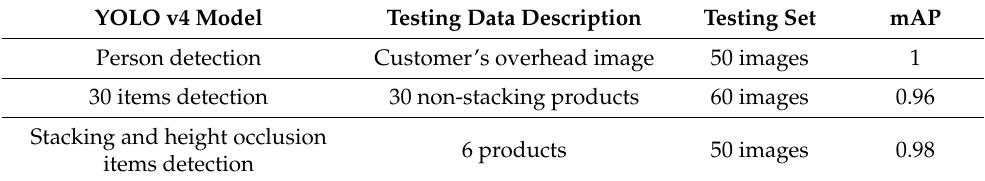
Table 3. The results of YOLO v4